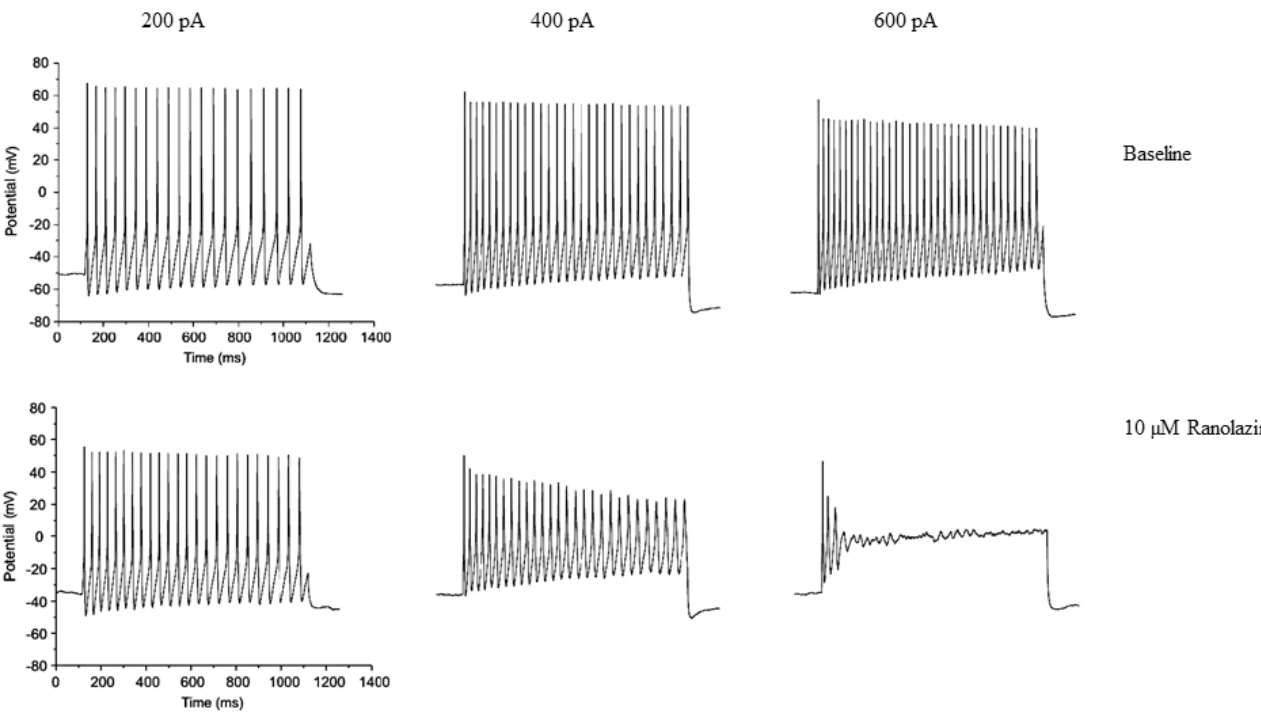
Figure 2. Clinically relevant concentration of ranolazine blocks high-frequency firing of Dorsal Root Ganglion (DRG) neurons expressing the wild-type (WT) Nav1.7 isoform. Traces illustrating the response (high-frequency firing phenotype) to 1-s duration current injections of 200 pA, 400 pA, and 600 pA both before ( upper row ) and after ( lower row ) exposure to 10 µM ranolazine in DRG neuron transfected with human Na v 1.7-WT channels. Reproduced from Figure 6B [125], an open-access ar-